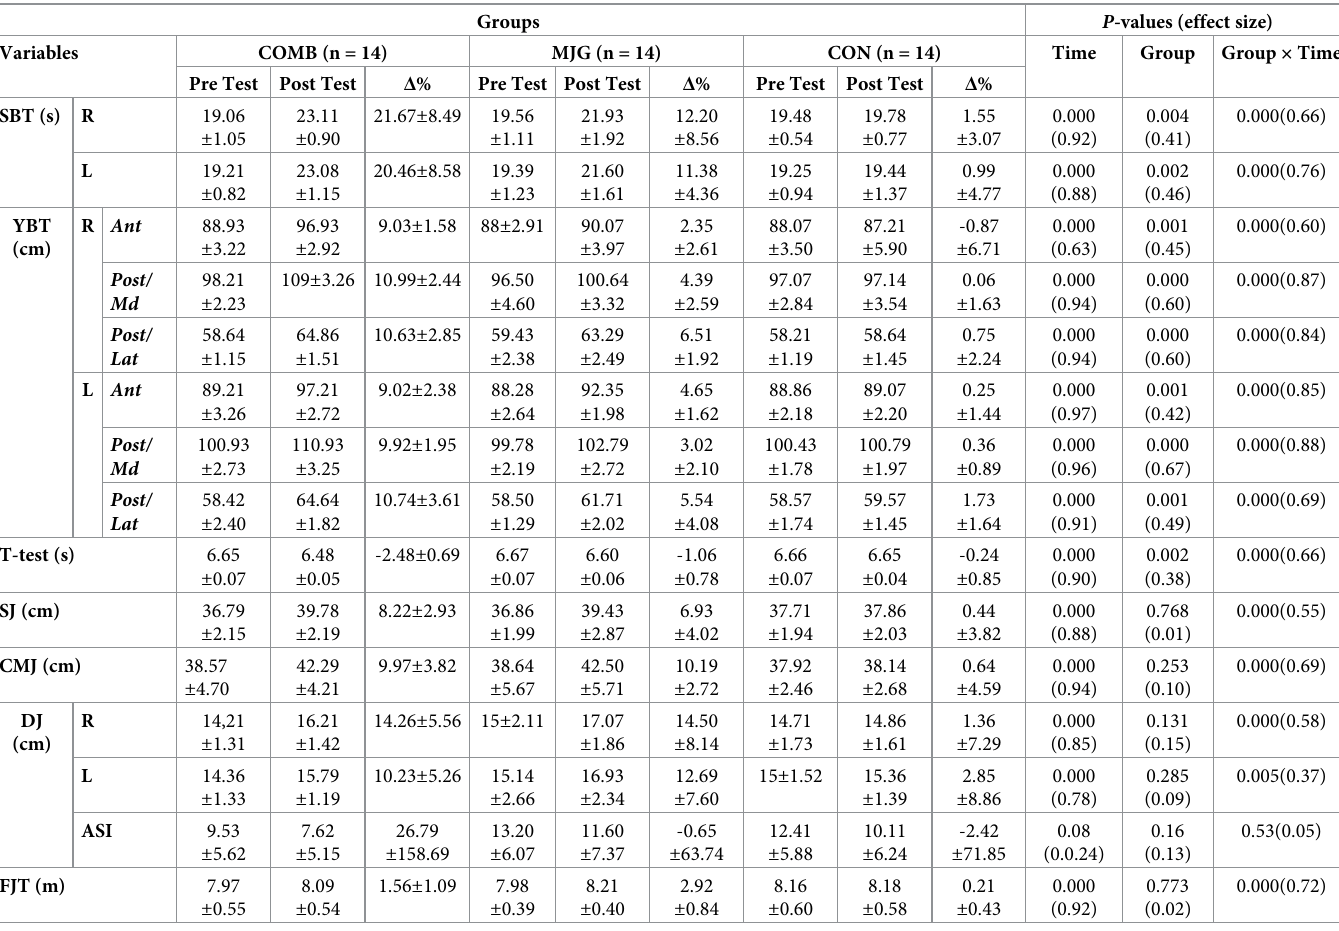
Table 5. Body balance, change-of-directions and Jump performances determined before (pre-test) and after (post-test) training